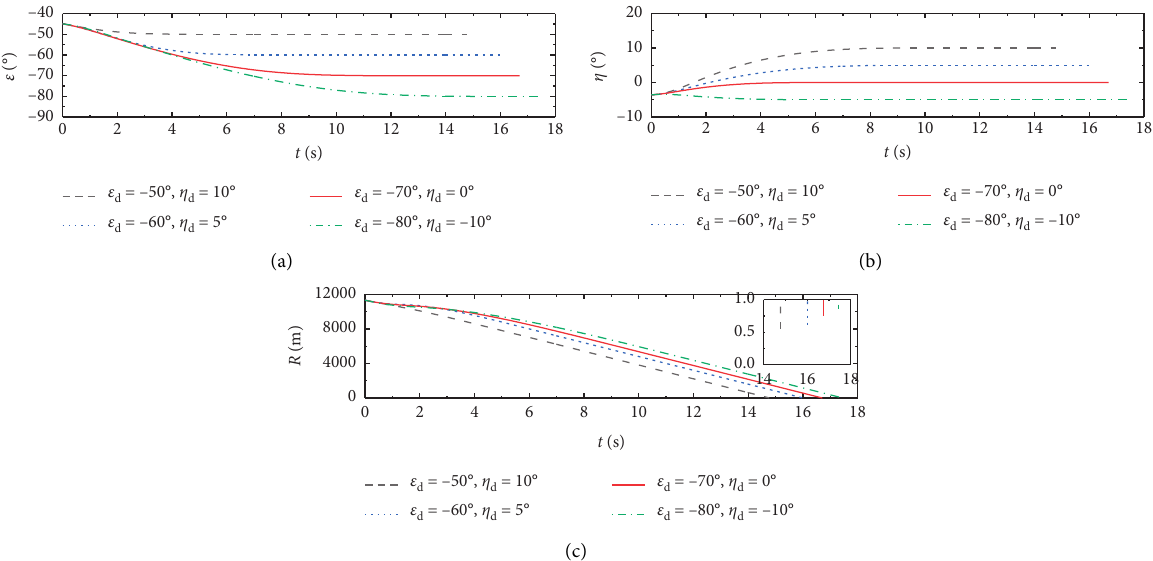
Figure 3: Curves representing LOS elevation and azimuth angles, distance between missile and target of Case 1.